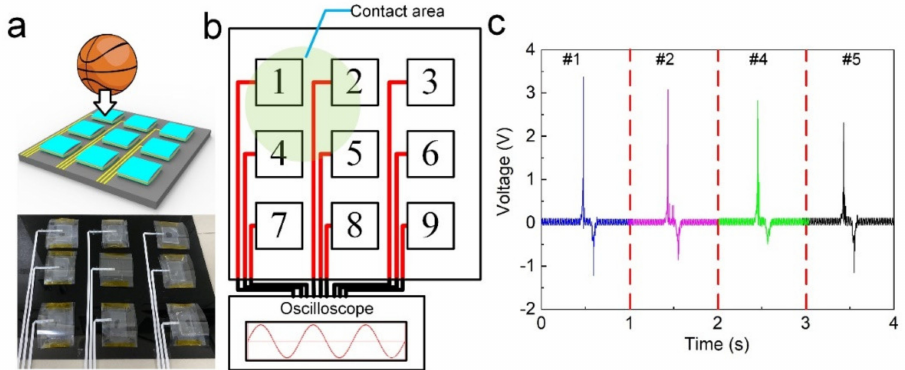
Figure 7. Application in basketball training: ( a ) the model and physical images of the basketball impact detection, ( b ) schematic diagram of the contact positions, and ( c ) the detected